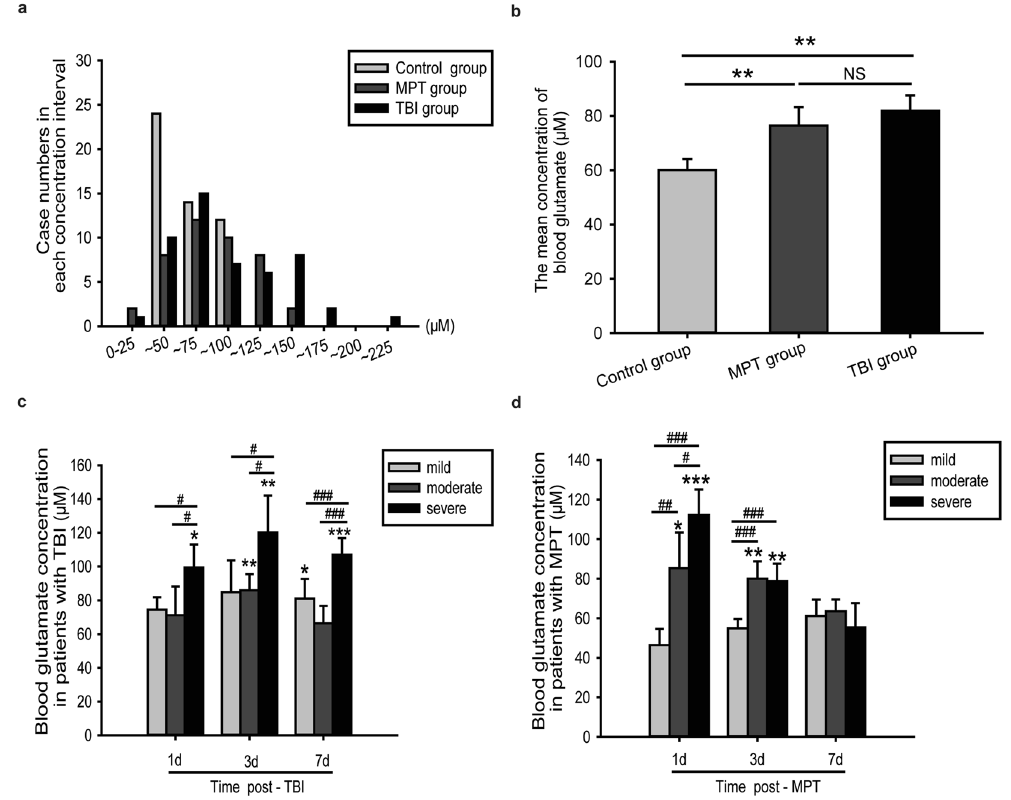
Figure 1. Distribution of patients at each concentration interval (every 25 μ M) ( a ) and the mean blood glutamate concentrations ( b ) in the control, MPT and TBI groups. The time-dependent changes in blood glutamate concentration in patients with different severities of TBI ( c ) or MPT (d ) are shown. * p < 0.05, ** p < 0.01, and *** p < 0.001 compared to the control group; # p < 0.05, ## p < 0.01, and ### p < 0.001 compared between the two groups; NS, not significant. Data are expressed as the means ± SE. Significance was determined by ANOVA with Tukey-Kramer post hoc tests or nonparametric Mann-Whitney U tests. MPT, multiple peripheral trauma; TBI, traumatic brain injury.